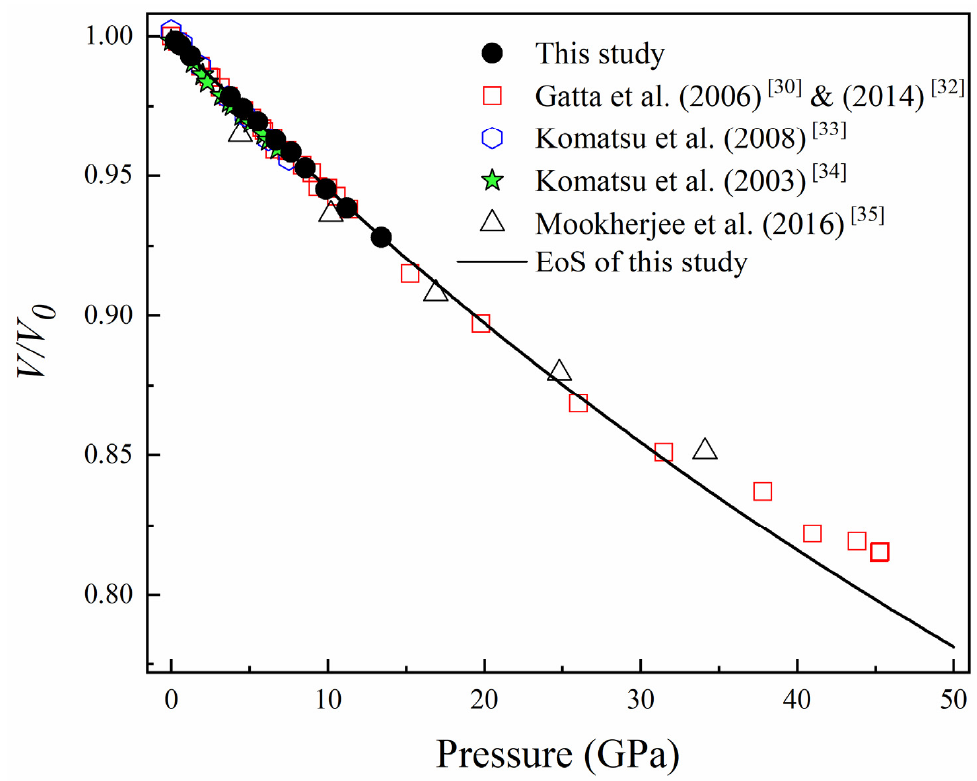
Figure 2. The V / V 0 changed with the pressure, the black solid points represent the data points measured in this experiment, and the black lines were obtained by BM3 EoS-fitting. The red hollow square represents the data points of Gatta et al. (2006) [30] & (2014) [32], the blue hollow hexagon represents the data points of Komatsu et al. (2008) [33], the green solid pentacle represents the data points of Komatsu et al. (2003) [34], and the black hollow triangle represents the data points of Mookherjee et al. (2016) [35].